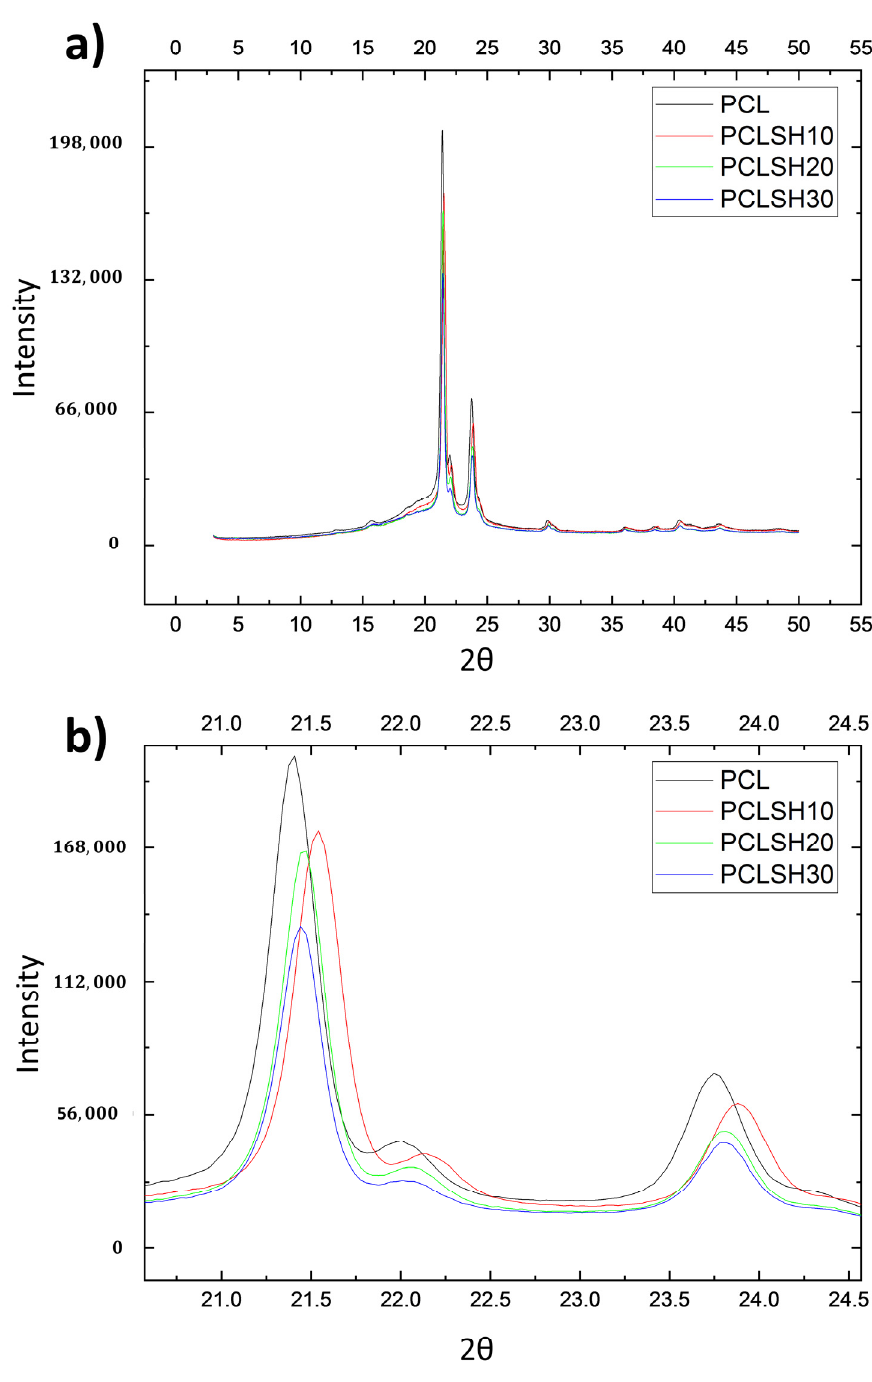
Figure 3. XRD patterns of electrospun meshes. ( a ) General view and ( b ) magnified image of the peaks for all samples.